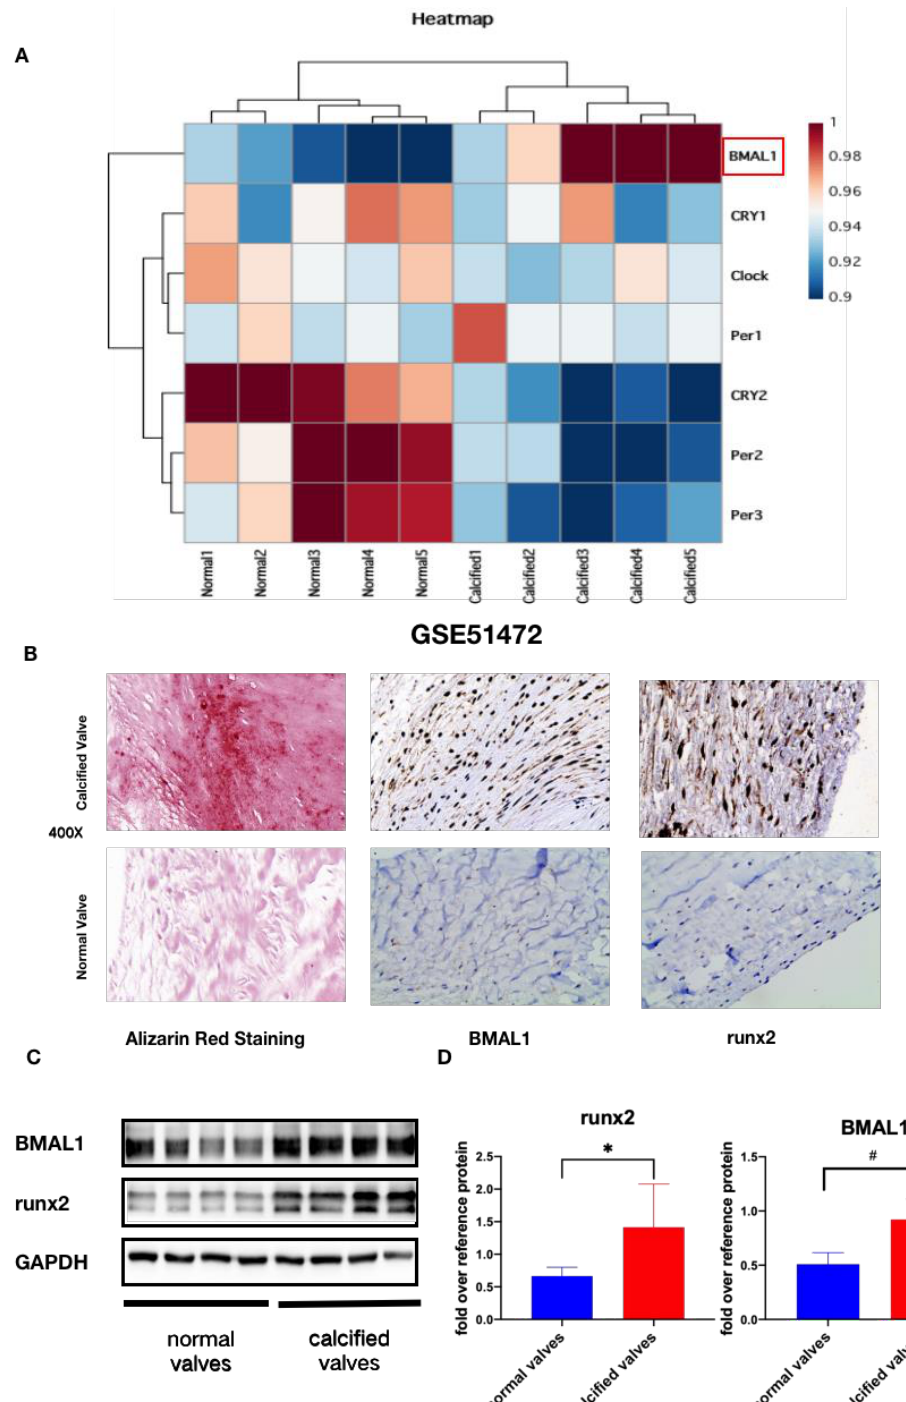
Figure 1. The expression of BMAL1 is increased in human calcified valves. ( A , B ), representative images of immunohistochemical staining of BMAL1 and runx2 in normal and calcified valves. ( C , D ), the protein levels of BMAL1 and runx2 were increased in calcified valves compared with normal valves (normal valves, n = 7; calcified valves, n = 8; * p < 0.05, # p < 0.01).